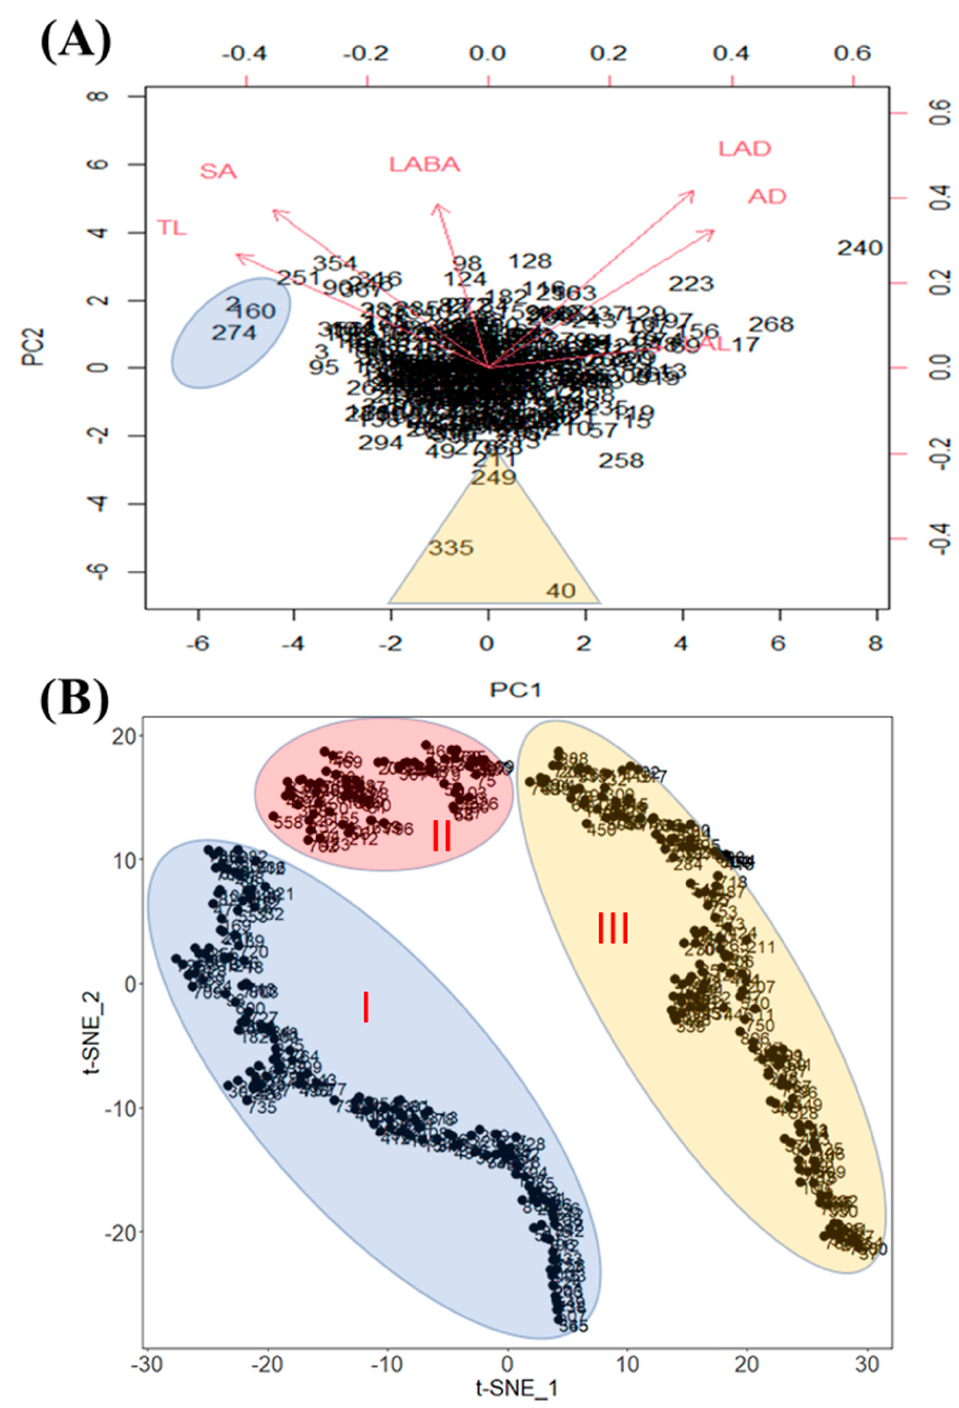
Figure 4. Principal Component Analysis biplot that separated the soybean cultivars into clusters based on root traits. In the figure, ( A ) indicated that PC1 accounted for 46.87% of the total variation, and PC2 accounted for 23.89% of the total variation. However, ( B ) was analyzed by the t-SNE method and each cluster indicates genotypes that have similar root traits.